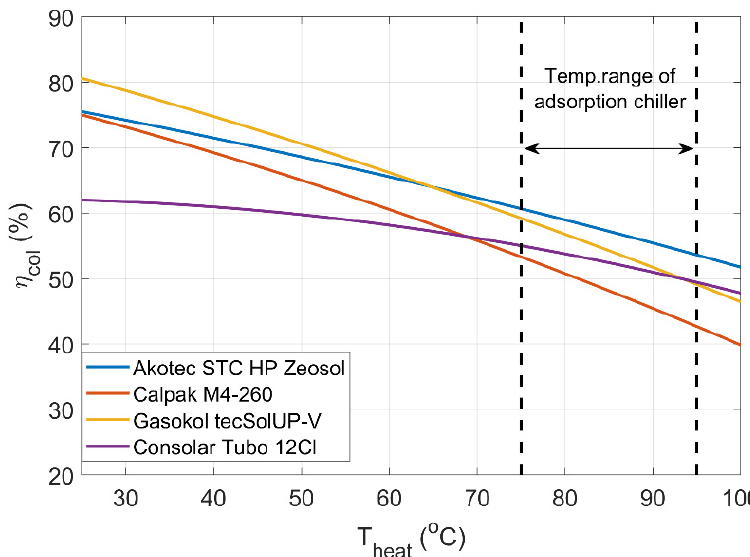
Figure 4. Performance curve of the developed solar collectors for the ZEOSOL system (blue line) in comparison to other commercial solar collectors.